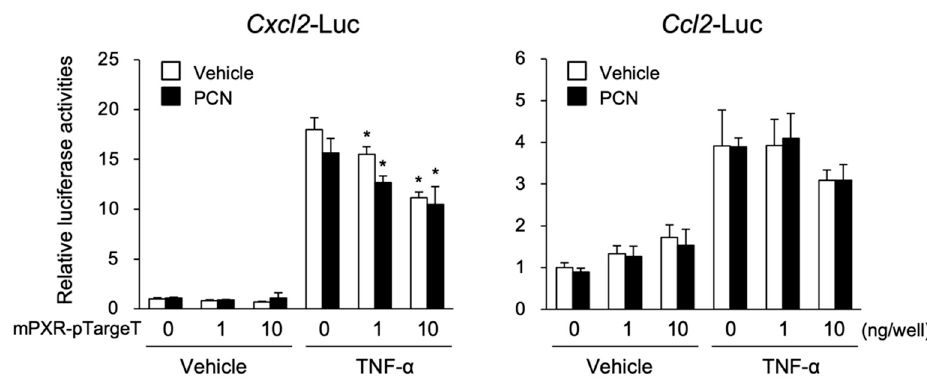
Figure 3. The influence of pregnane X receptor (PXR) activation on Ccl2 and Cxcl2 expression. 293T cells were transfected with Cxcl2 -Luc or Ccl2 -Luc, mPXR-pTargeT or control pTargeT, and control phRL-TK (total DNA: 100 ng / well) and then treated with 10 µ M PCN or vehicle (0.1% dimethyl sulfoxide, DMSO) in combination with or without 10 ng / mL tumor necrosis factor- α (TNF- α ) or vehicle (0.1% DMSO) for 24 h, and reporter activity was determined. Relative activity is shown compared to that in the cells transfected with control pTargeT (mPXR-pTargeT: 0 ng) and treated with vehicle only (the left-end open bar) as 1. Values are presented as mean ± SD ( n = 4). Statistical di ff erences within the TNF- α -treated groups were analyzed using one-way analysis of variance (ANOVA) followed by Dunnett’s test with the vehicle-treated cells with no PXR expression (the far-left column) as a control group. * p < 0.05.